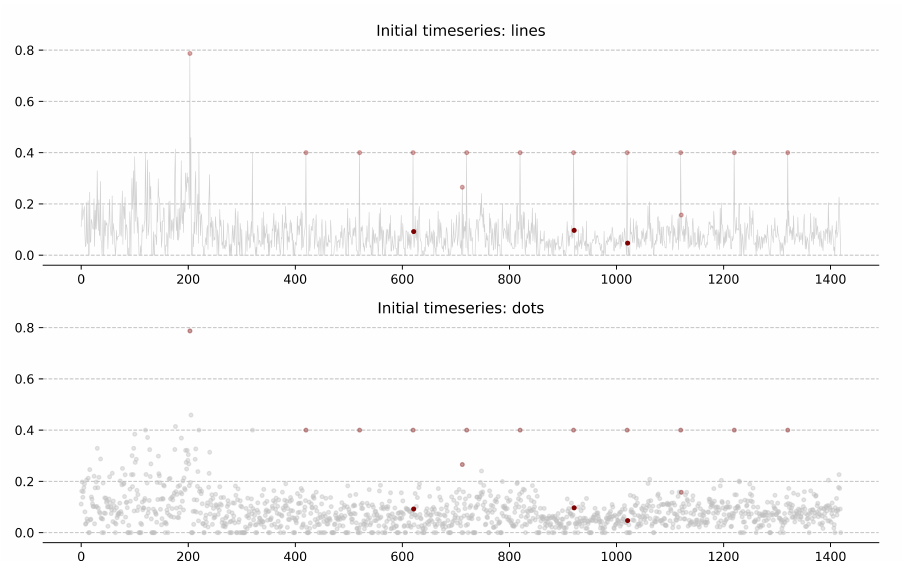
Figure 19. Numenta Anomaly Benchmark time series with hidden context anomalies within repeating point anomalies set. Anomalies were found with an anomaly likelihood threshold of